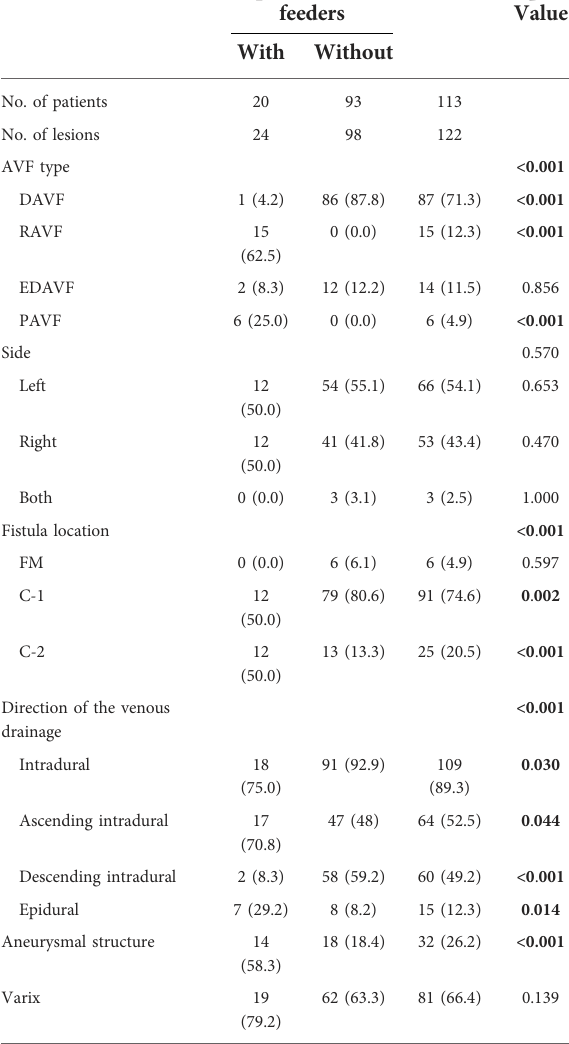
FM, foramen magnum; C, cervical. Bold text indicates statistical signi fi cance.